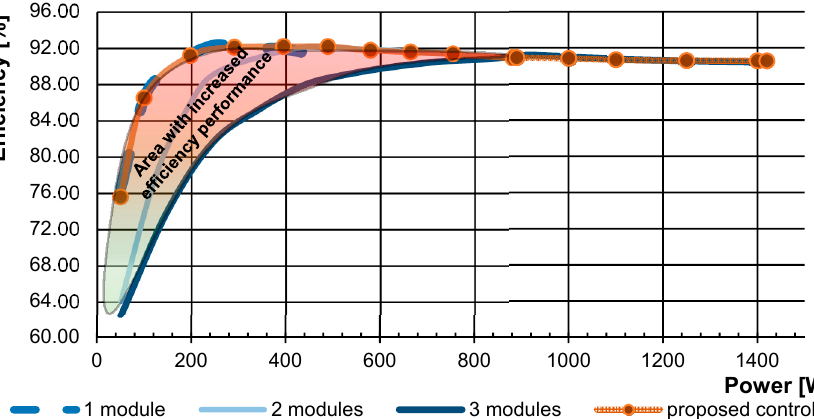
Figure 17. Efficiency performance of individual module operation (frequency follower) in comparison with MASTER-voltage, SLAVE-current technique .